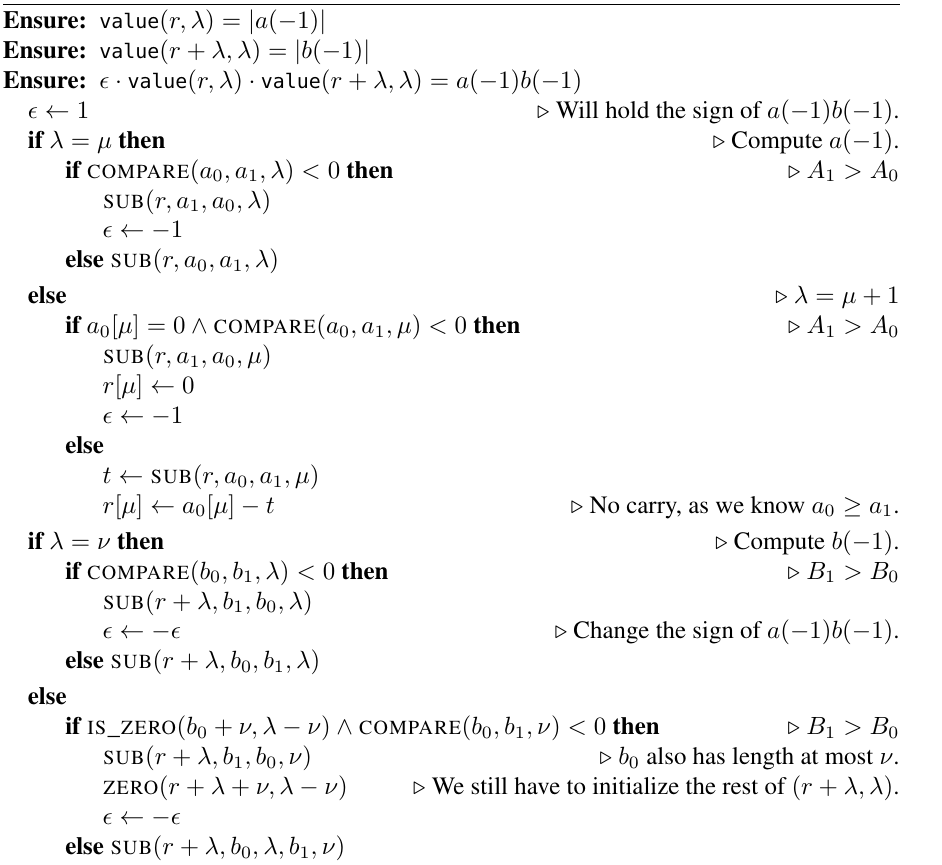
Algorithm 12 Computation of | a ( − 1) | in r and | b ( − 1) | in r +